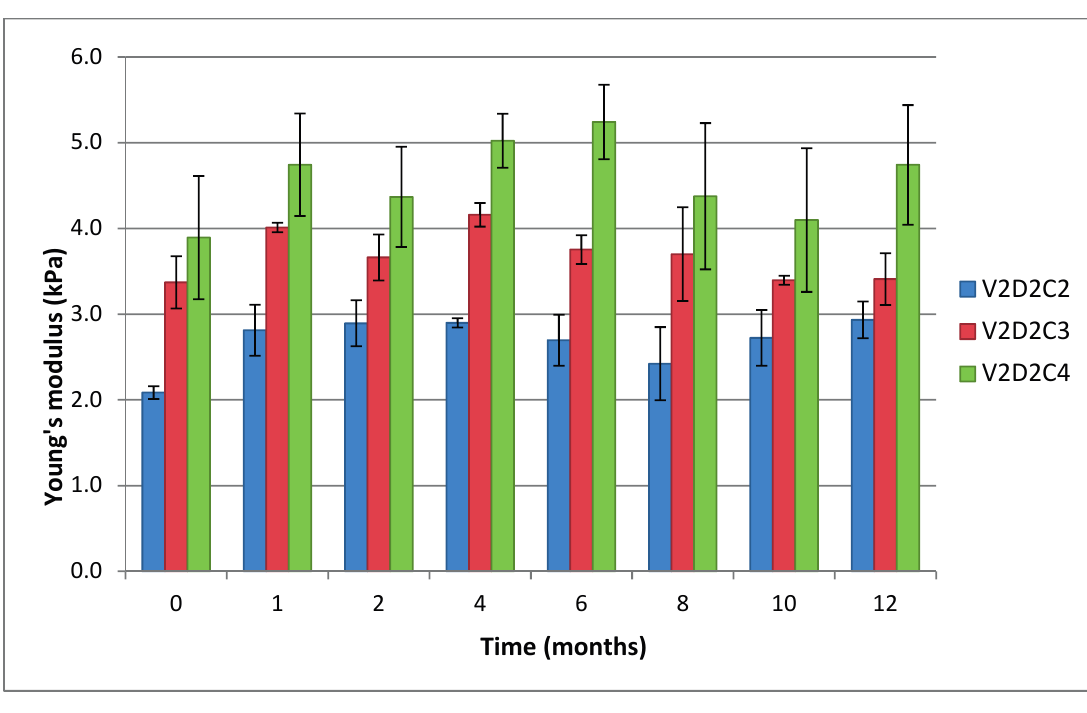
Figure 6. Comparison of the Young’s modulus over 12 months for gels of 1% ( w / w ) chitosan V2D2 and variable concentration of crosslinker. C2, C3 and C4 represent 2%, 3% and 4% theoretical cross-linking,